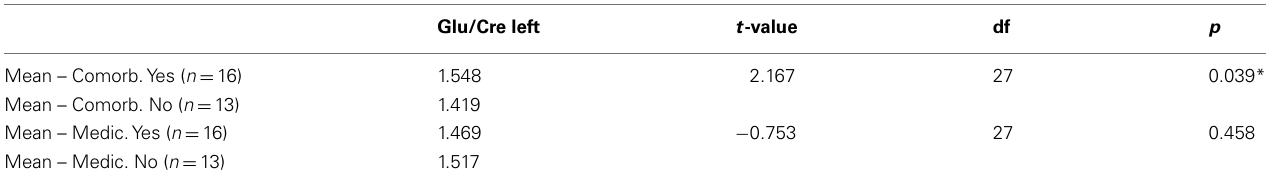
TableA1 | Independent t -tests of theADHD group ( n = 29) with glutamate/creatine ratio left side as dependent variable, and comorbidity and medication, respectively, as grouping variables.